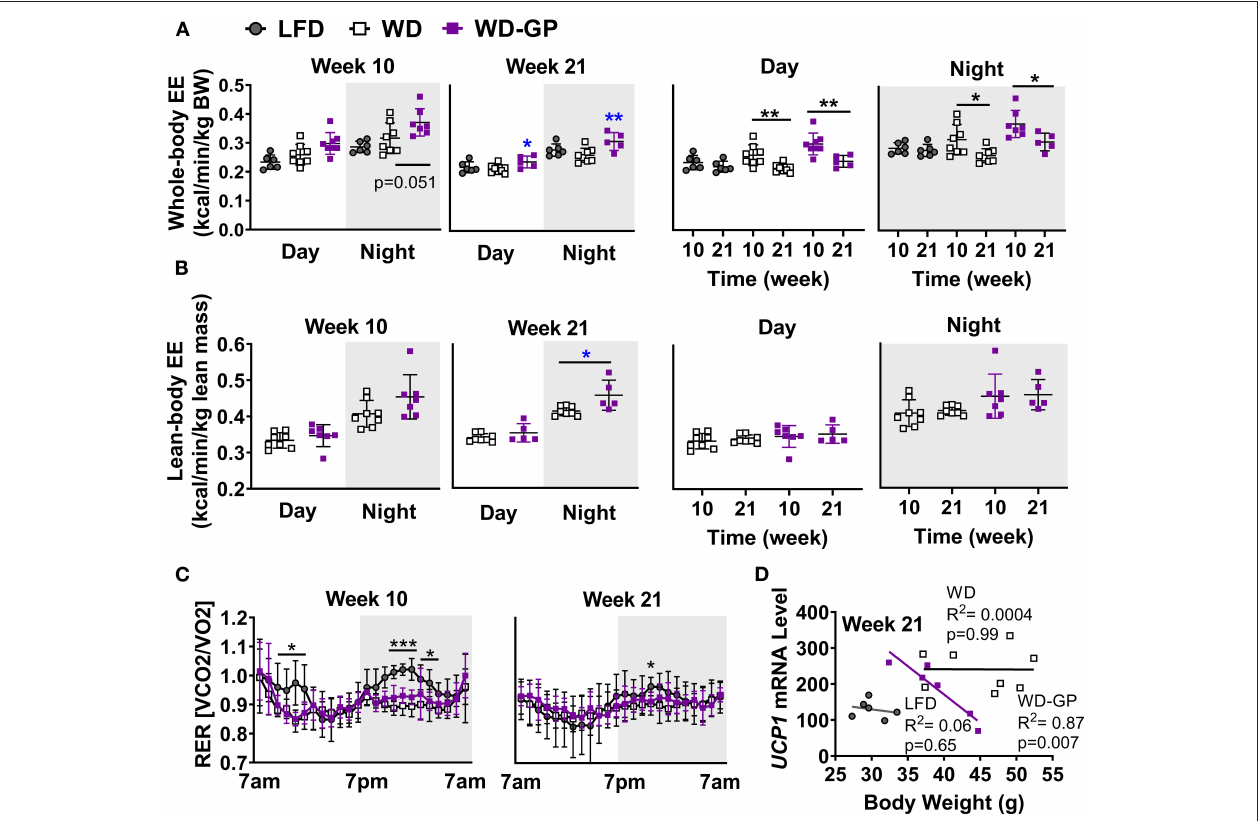
FIGURE 2 | GP supplementation increased energy expenditure. (A) Energy expenditure (EE) as kcals expended per minute normalized to kilogram of body weight and (B) kilogram of lean mass during day and night phases at week 10 and 21 of the diet-intervention. Left two panels of A,B show between group comparisons at weeks 10 and 21, and the right two panels compare weeks 10 and 21 within group. (C) Respiratory exchange ratio (RER) at weeks 10 and 21 of diet intervention are shown over time in metabolic chamber. (D) Two-tailed Pearson Correlation Analysis between UCP1 mRNA levels in BAT and body weights at week 24. Data are presented as mean ± SD. Significant difference between diet-groups was determined by one-way ANOVA followed by Dunnett’s multiple comparisons test using the WD group as control, except in A Day and Night graphs and in B where an unpaired, two-tailed, t -test with Welch’s correction was used. Black colored asterisks indicate statistical significance between same diet groups or LFD vs. WD groups while blue-colored asterisks indicate statistical significance between the WD vs. WD-GP group * p < 0.05, ** p < 0.01, *** p < 0.001. BW, Body